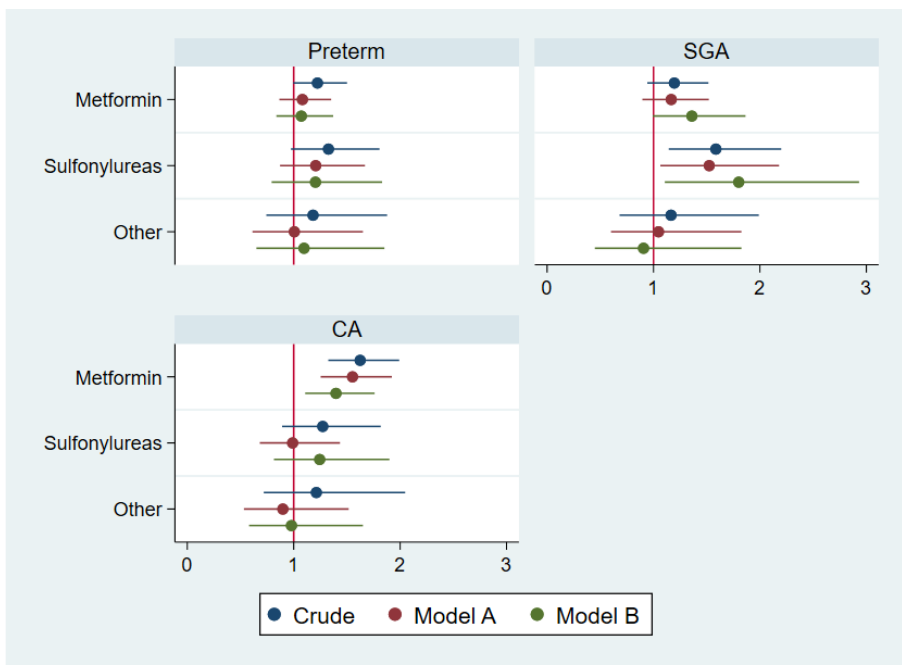
Figure 1. Shows the crude and adjusted ORs for preterm birth and small for gestational age (SGA), and the HRs for congenital abnormalities, according to paternal use of non-insulin anti-hyperglycemic agents (metformin, sulfonylureas, others) prior to conception. In model A, we adjusted for maternal and paternal age, maternal and paternal comorbidity, mother’s use of antidiabetics, parity, sex of the child, calendar year, and other types of non-insulin anti-hyperglycemic agents prior to conception. In model B, we added maternal BMI and maternal smoking.